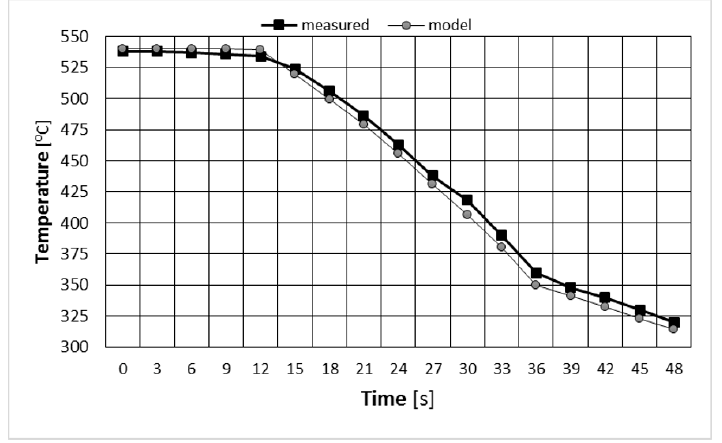
Figure 19. Evolution of temperature in the centre of the plate during the quenching process.